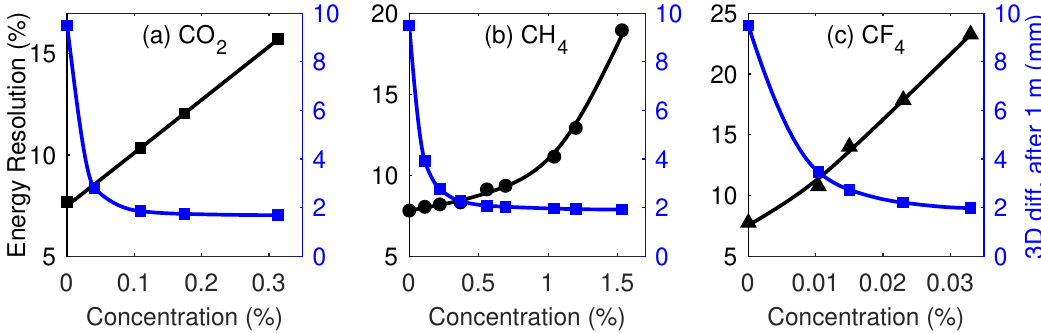
Figure 6 . Energy resolution (in black) as a function of additive concentration, obtained under an electric (cid:12)eld of 2.5 kV/cm/bar in the GPSC scintillation region, for xenon admixtures with: (a) CO 2 ; (b) CH 4 ; (c) CF 4 . The corresponding 3D di(cid:11)usion predicted from Magboltz simulations [39] after 1 m drift is shown in the right hand vertical axis (in blue), and was obtained for a xenon TPC with a nominal pressure of 10 bar and a reduced electric (cid:12)eld of 20 V/cm/bar in the drift